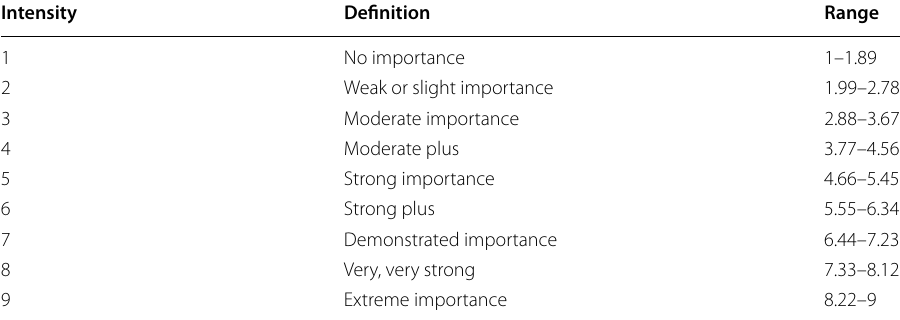
Table 2 Scale of importance